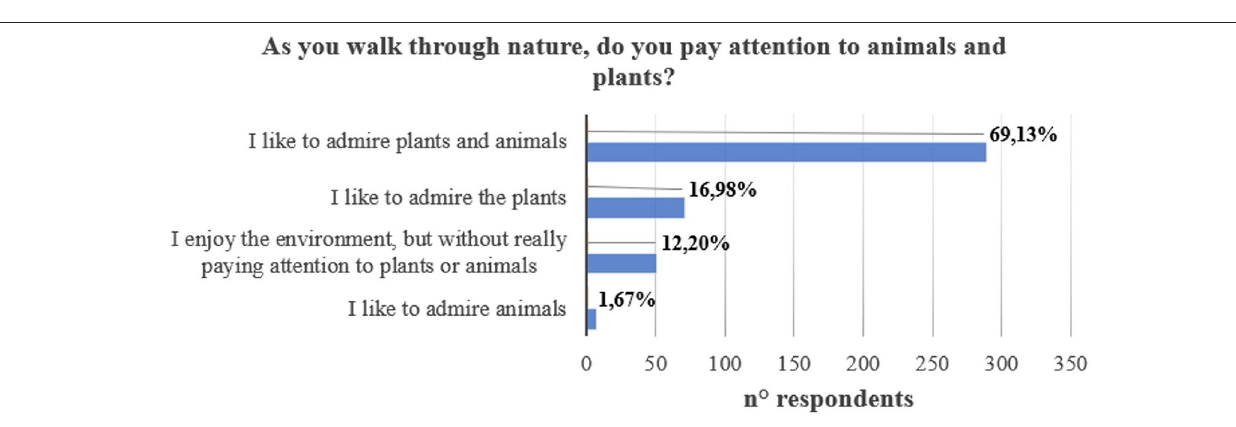
terrain seems to be the best way to protect ecosystem services, and further enhance the value of open spaces in cities (IAU,